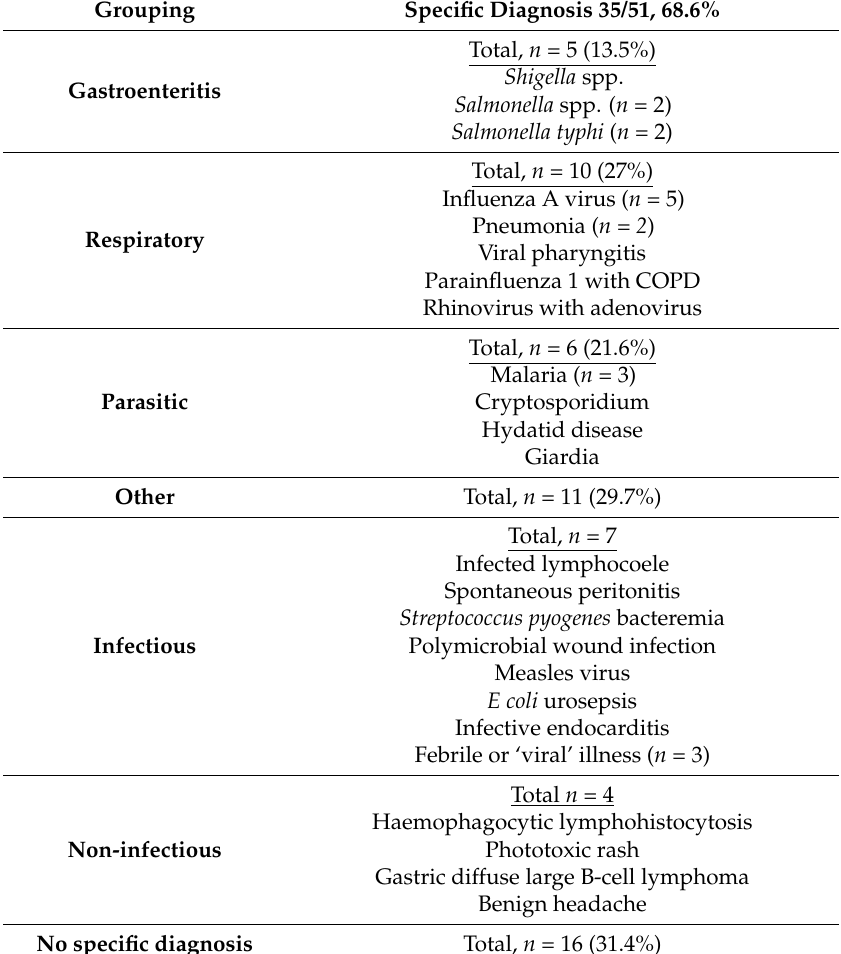
Table 6. Laboratory or clinical diagnosis of patients that were seronegative for DENV ( n = 51). Diagnosis is grouped and specific diagnosis indicated with n = 1 patients, unless